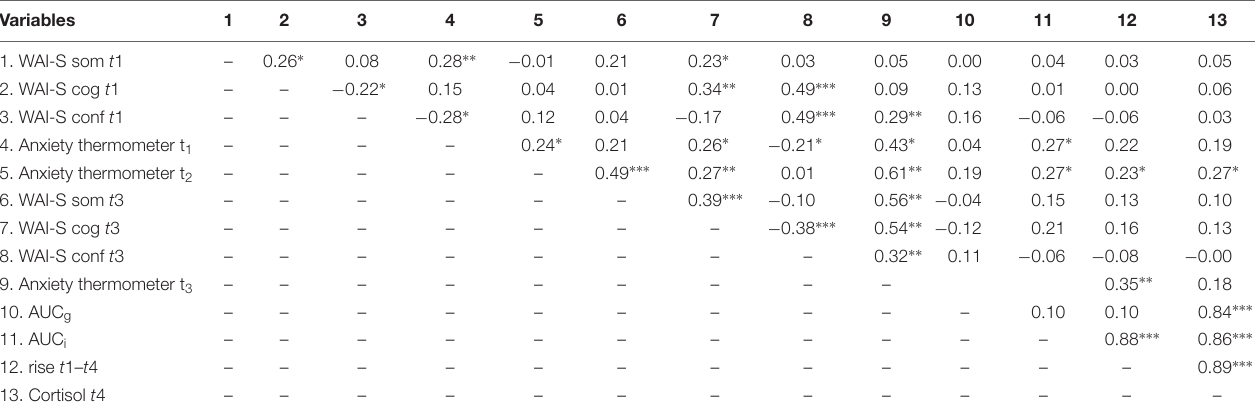
TABLE 4 | (Partial) correlations of the psychological and physiological dependent variables.